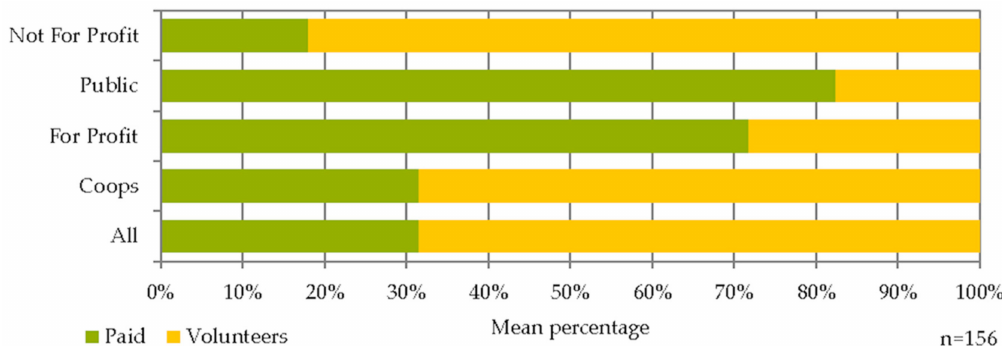
Figure 8. Balance of paid sta ff vs volunteers overall and for to the top four legal forms.